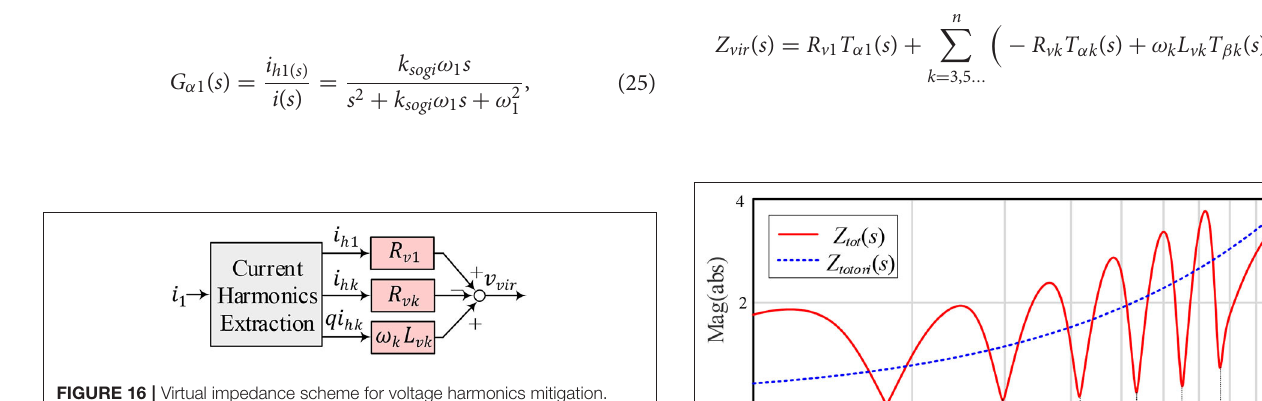
FIGURE 16 | Virtual impedance scheme for voltage harmonics mitigation.